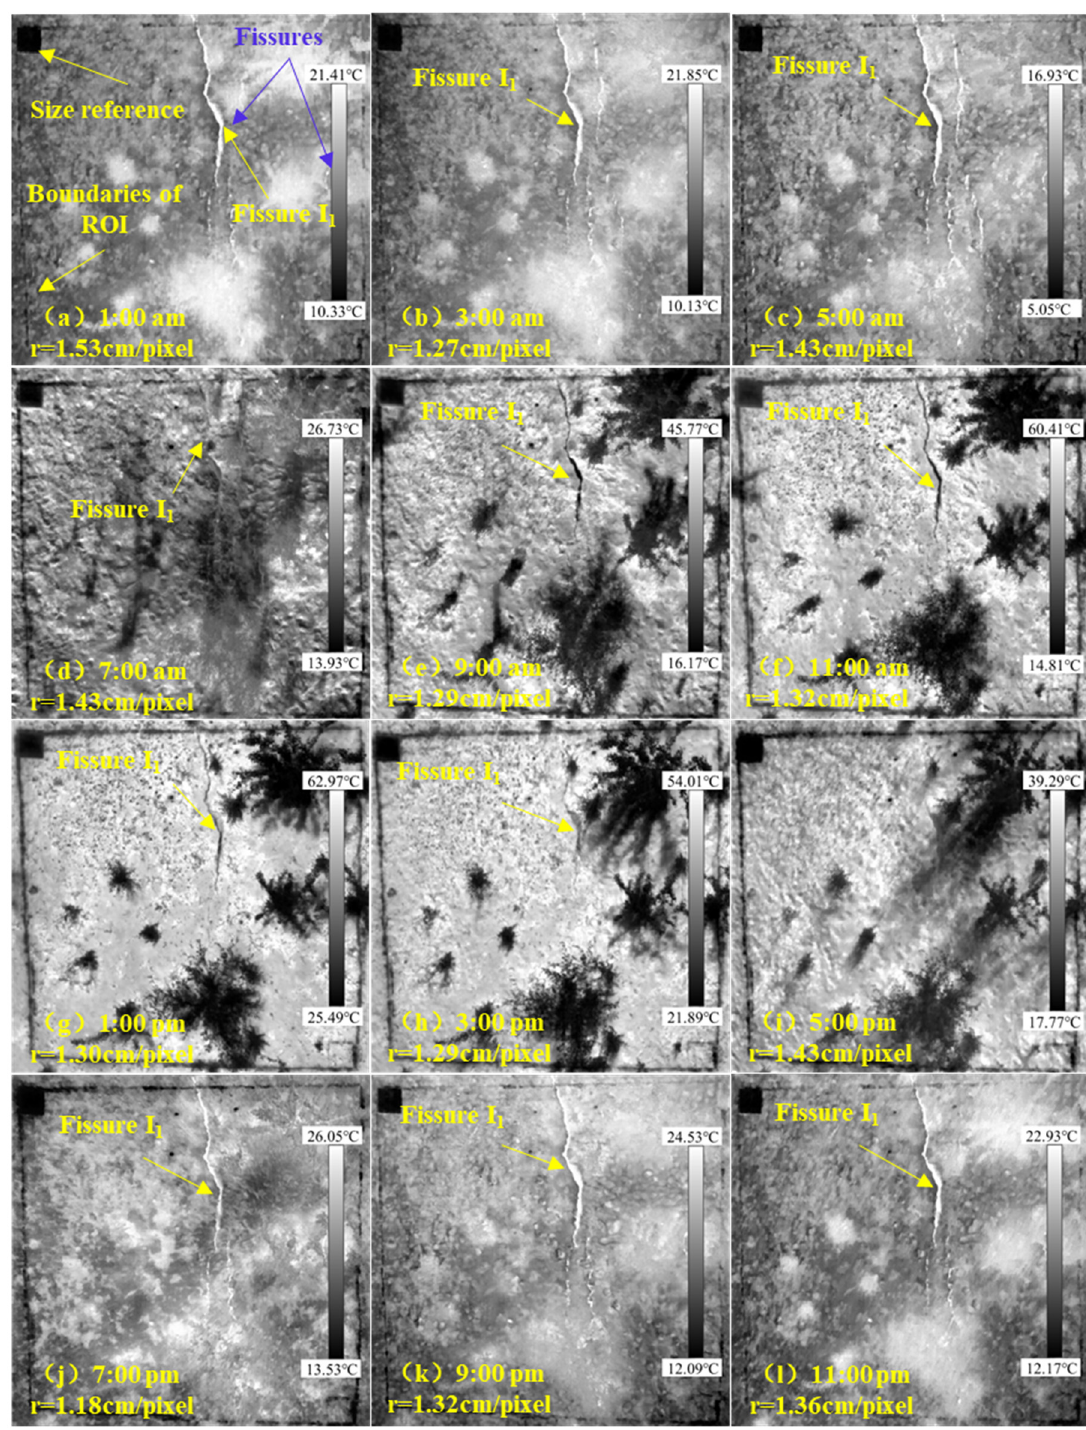
Figure 5. Infrared images at different time points. r represents the image resolution. ( a ) 1:00 a.m., r = 1.53 cm/pixel; ( b ) 3:00 a.m., r = 1.27 cm/pixel; ( c ) 5:00 a.m., r = 1.43 cm/pixel; ( d ) 7:00 a.m., r = 1.43 cm/pixel; ( e ) 9:00 a.m., r = 1.29 cm/pixel; ( f ) 11:00 a.m., r = 1.32 cm/pixel; ( g ) 1:00 p.m., r = 1.30 cm/pixel; ( h ) 3:00 p.m., r = 1.29 cm/pixel; ( i ) 5:00 p.m., r = 1.43 cm/pixel; ( j ) 7:00 p.m., r = 1.18 cm/pixel; ( k ) 9:00 p.m., r = 1.32 cm/pixel; ( l ) 11:00 p.m., r = 1.36 cm/pixel.